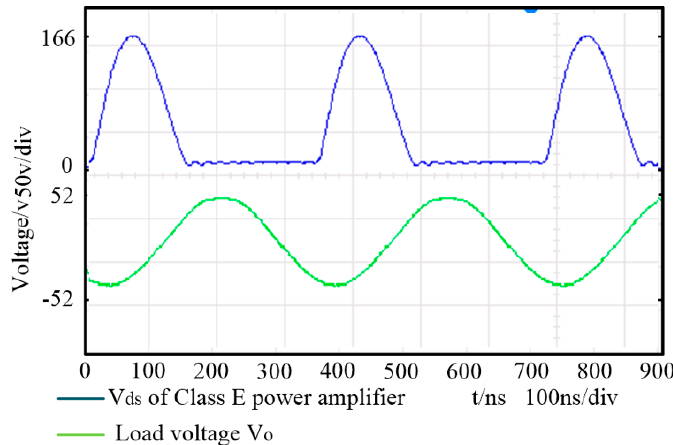
Figure 14. V ds and load voltage in traditional four coil structure system. Table 8. Comparison of two types of WPT systems.